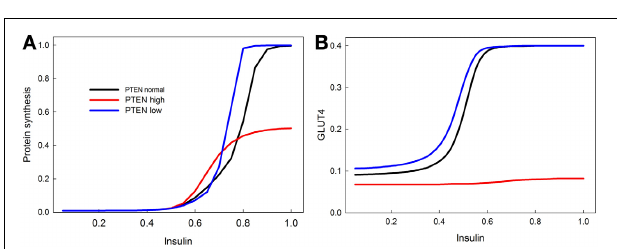
but with TOR knockout. The effect of the TOR knockout on protein synthesis is only noticeable when there is weak MAPK signaling (right corner of the figure); when TOR is knocked out and MAPK signaling is low, insulin alone cannot stimulate protein synthesis.